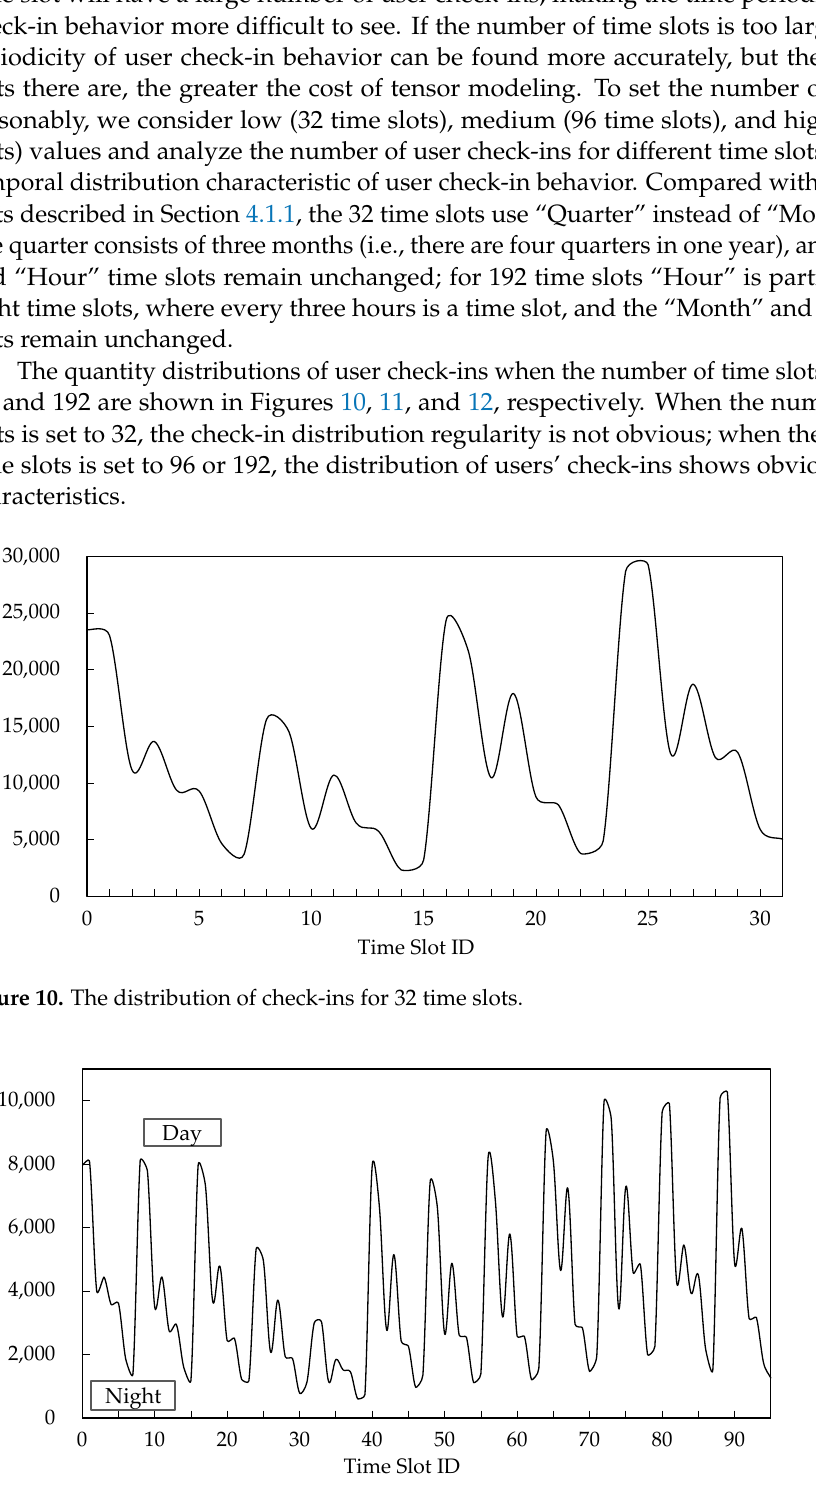
Figure 11. The distribution of check-ins for 96 time slots.